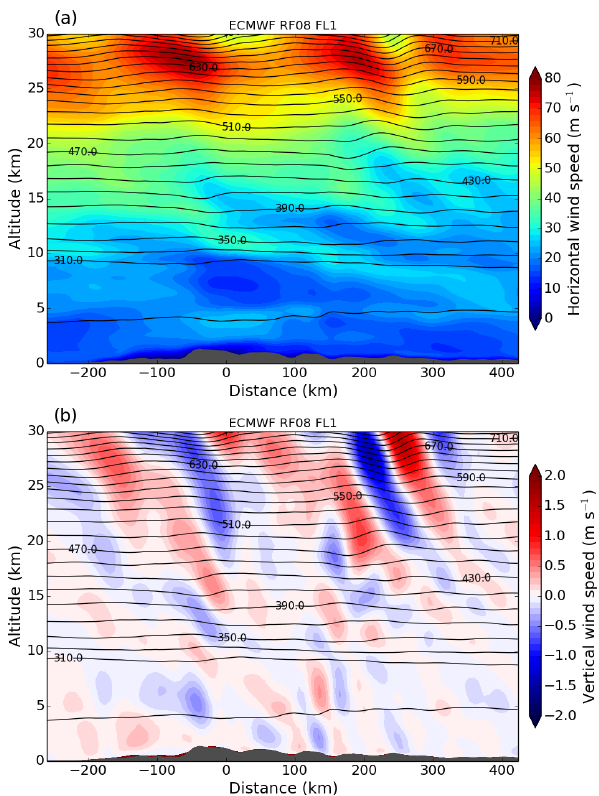
Figure 3. ECMWF vertical cross sections of (a) horizontal wind speed and (b) vertical wind speed interpolated in time and horizon- tal space along flight leg RF08 FL1. Black contour lines indicate potential temperature with an interval of 20K. The cross-section distance is centred at X 0 (see Fig.